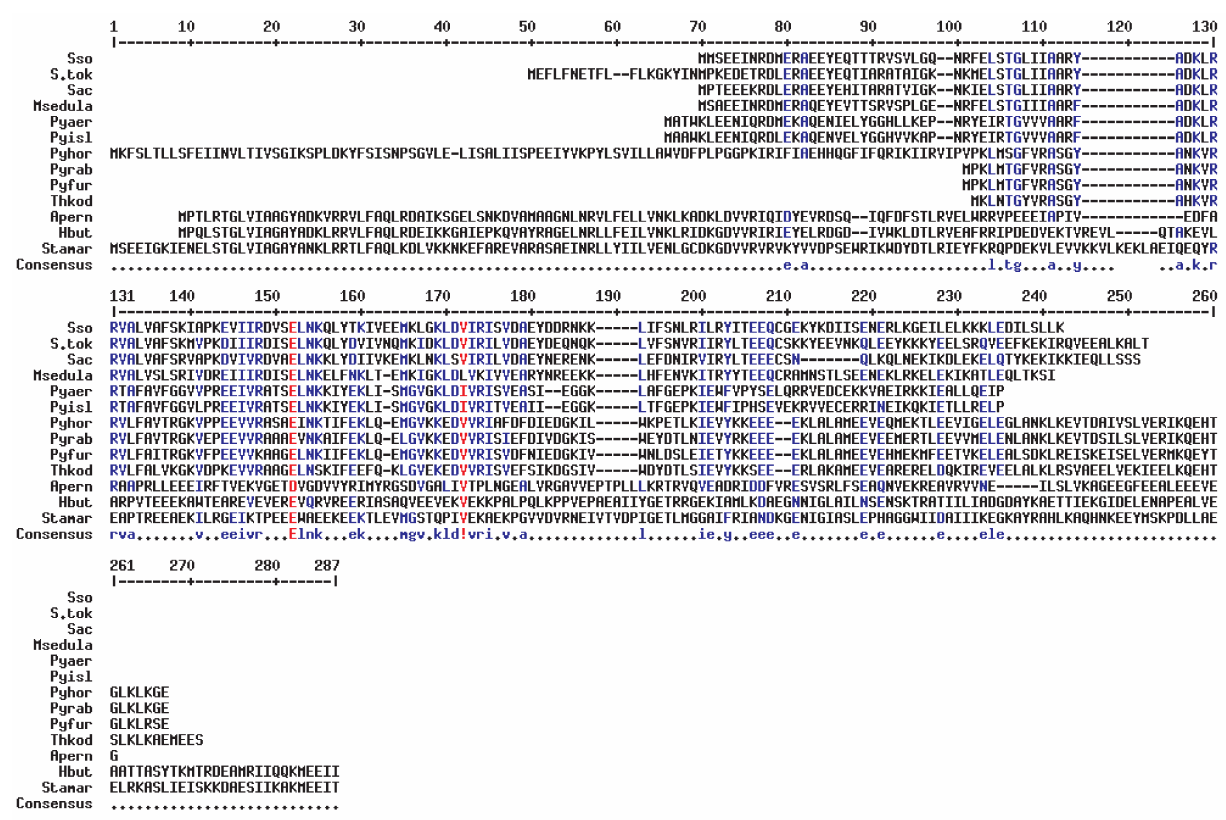
Figure 2. Alignment of the archaeal Rbp18 proteins. Amino acids that are identical or similar in most, but not all, sequences are shown in blue; amino acids that are identical or similar in all sequences are shown in